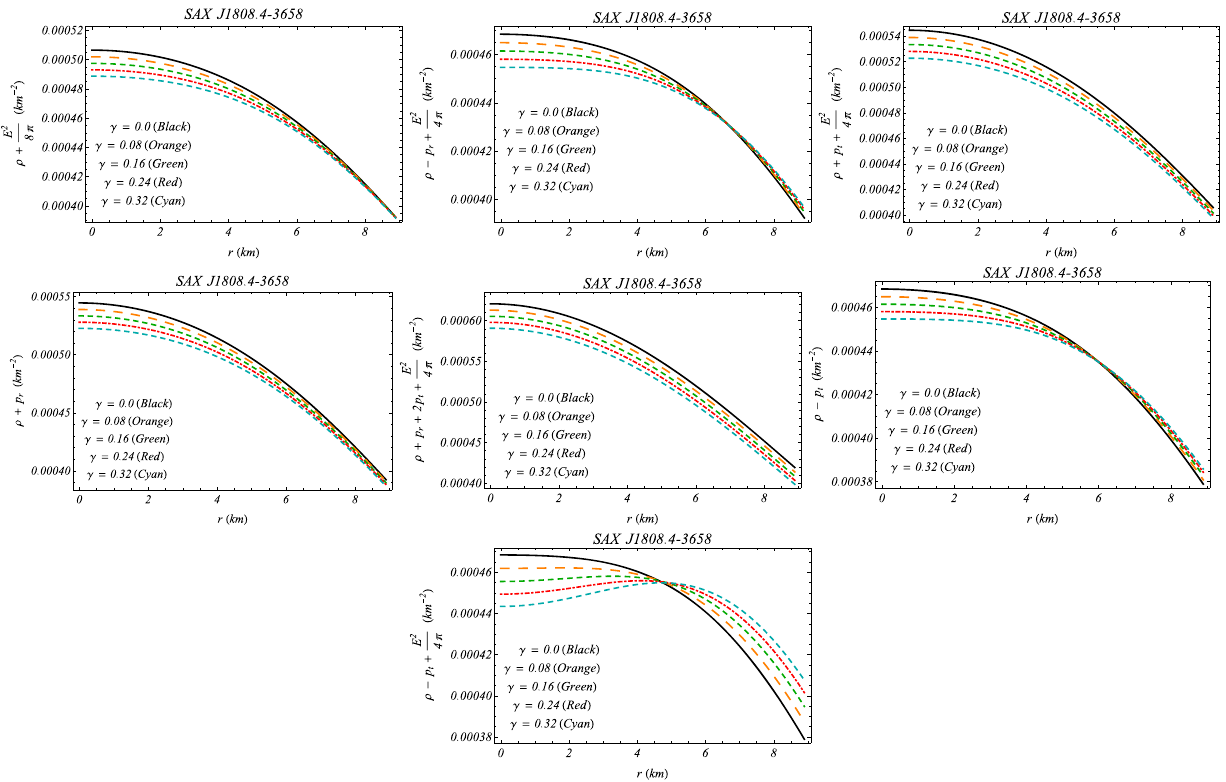
Fig. 8 All the energy conditions inside the stellar interior for the strange star SAX J1808.4-3658 for different values of γ mentioned in the